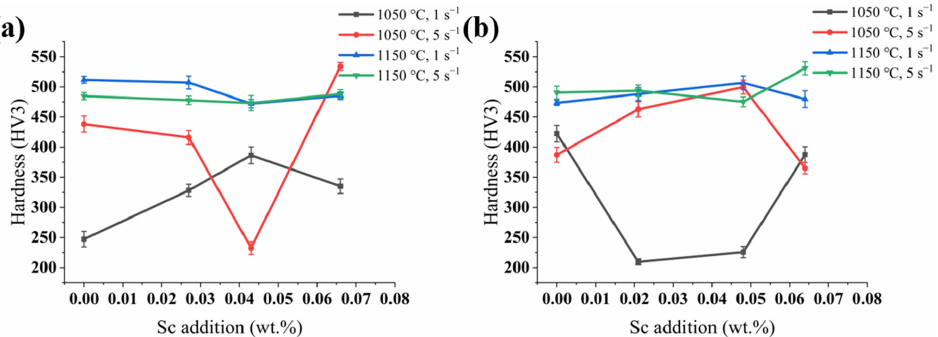
Figure 4. Hardness of superalloys with different scandium addition under different thermal consolidation processes: ( a ) U720Li, ( b ) RR1000. Table 3. Hardness of superalloys with di ff erent scandium addition under di ff erent thermal consol- idation processes (HV3). Scandium Alloy Addition (wt.%)